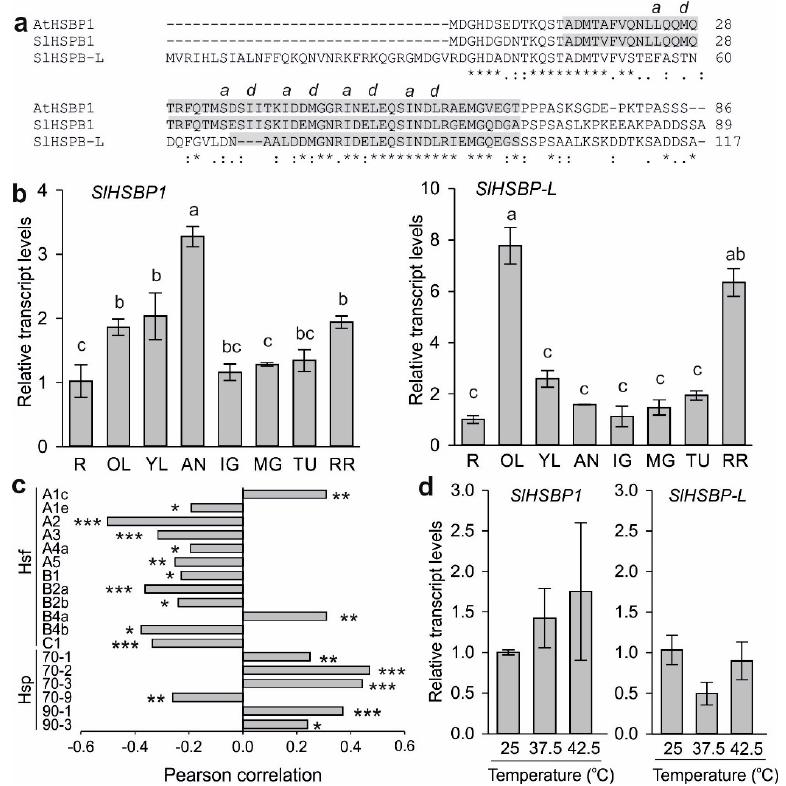
Figure 1. Domain structure and expression analysis of tomato heat shock binding protein (HSBP) genes. ( a ) Amino acid sequence alignment of A. thaliana and tomato HSBP proteins by Clustal W. The